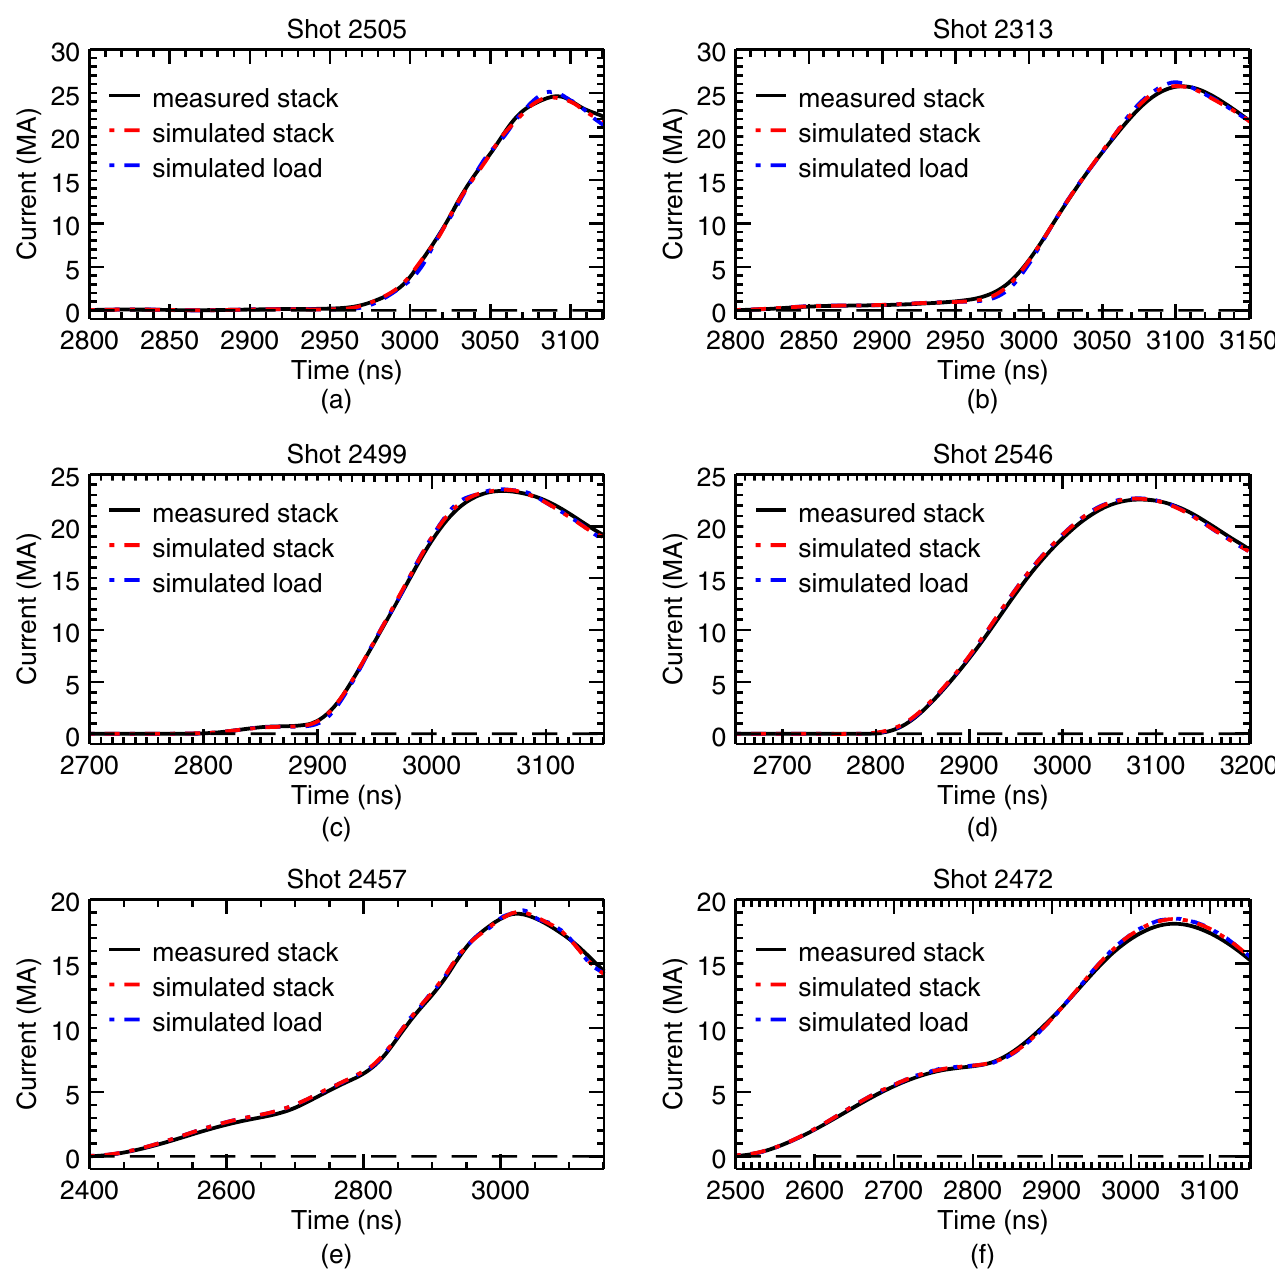
FIG. 4. Comparison of simulation and experiment results of six short-circuit shots. (a) standard pulse, (b) short pulse, (c) medium pulse, (d) long pulse, (e) shaped pulse 1, (f) shaped pulse